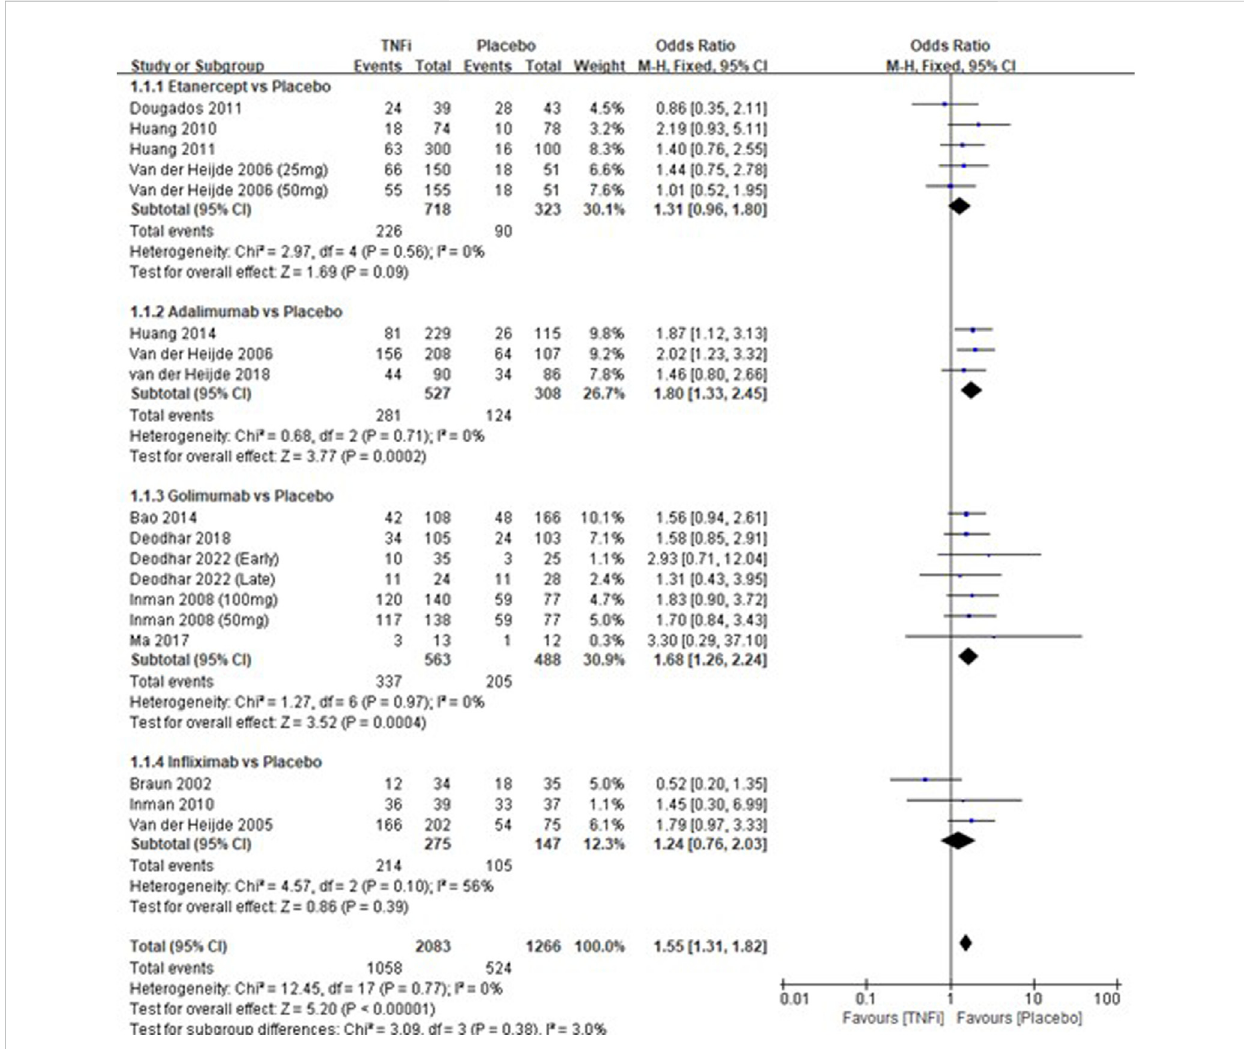
FIGURE 2 Pooled estimate of the incidence of overall adverse events between TNFi groups and placebo groups in patients with ankylosing spondylitis. The odds ratio > 1.0 indicates that the incidence of serious adverse events is higher in the TNFi group than that in the placebo group. The subheading “ Events ” refers to the number of overall adverse events. “ Total ” refers to the total number of individuals. CI, con fi dence interval; df, degrees of freedom; M-H, Mantel – Haenszel method of